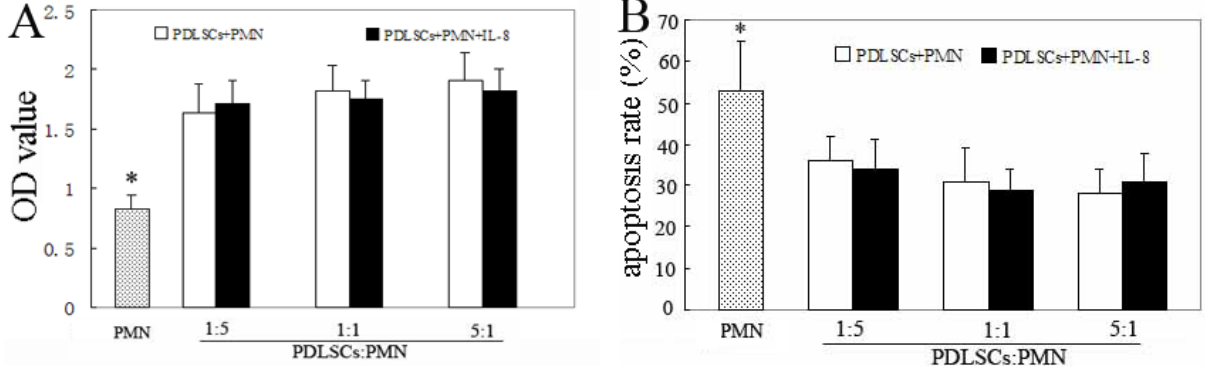
Figure 1: The effect of PDLSCs on the proliferation and apoptosis rate of PMN. (A) PDLSCs could elevate the proliferation of resting PMN and IL-8 stimulated PMN significantly. (B) The apoptosis rate of resting PMN and IL-8 stimulated PMN could be reduced by PDLSCs significantly. *: P < 0.05 vs other groups. Data are expressed as mean ± SD of triplicates from six independent experiments.